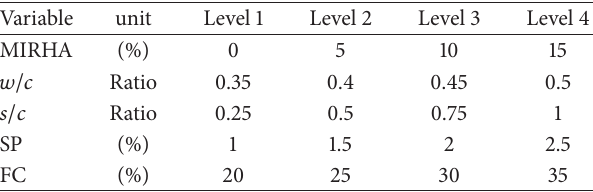
Table 2: Parameters and their variation